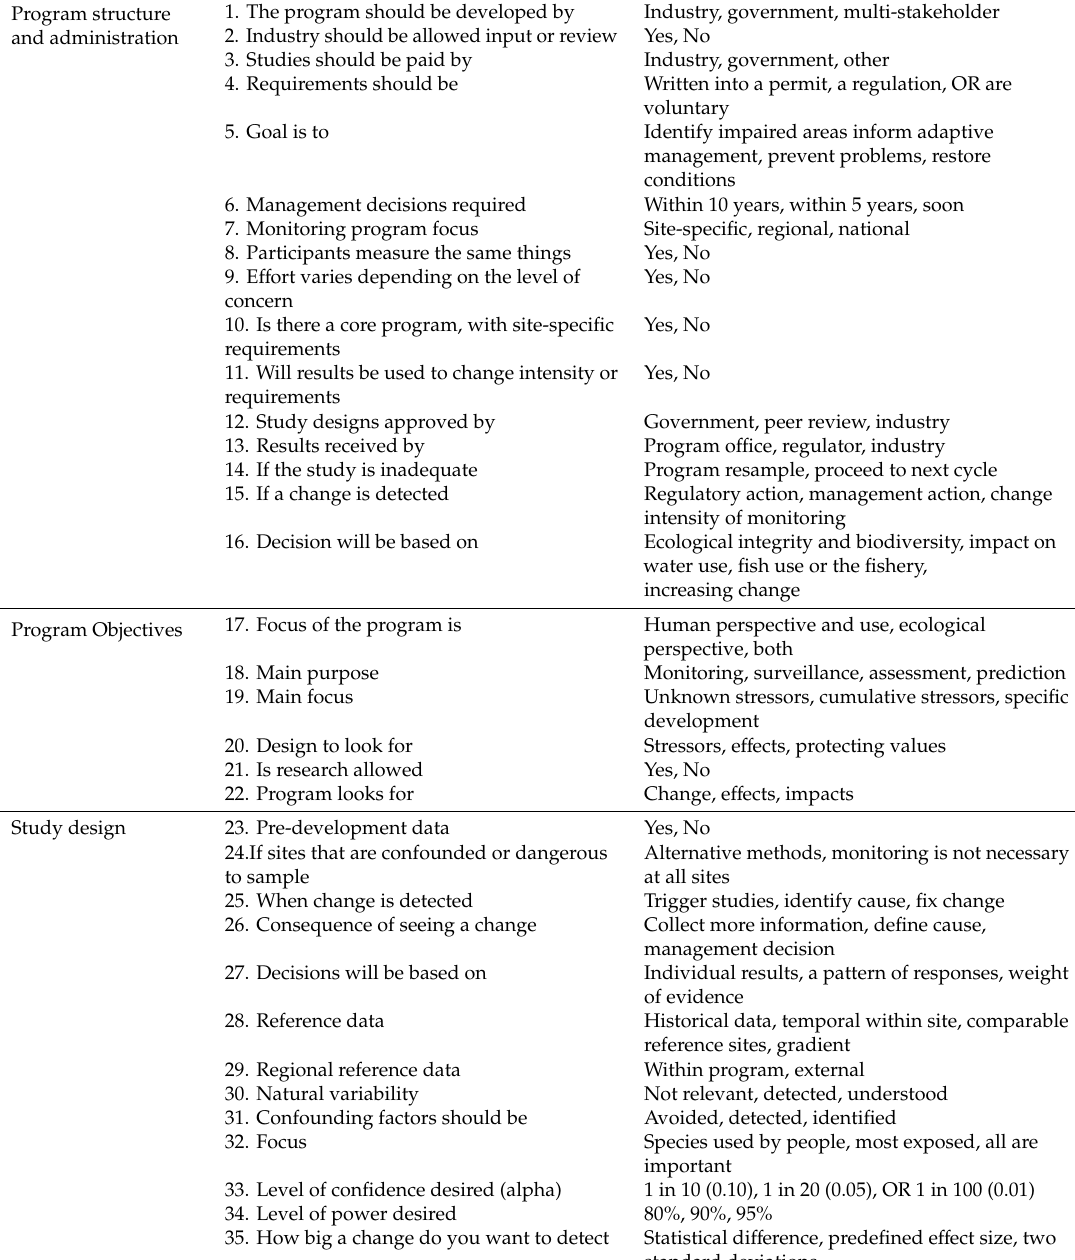
Table 1. Issues and concerns for developing a multi-stakeholder aquatic monitoring